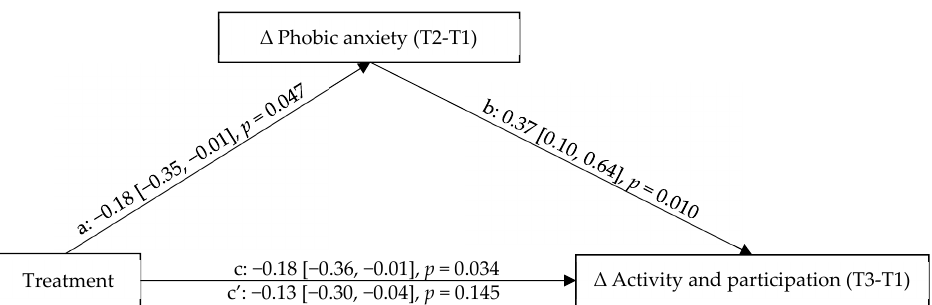
Figure 2. Mediated model with standardized regression coefficients predicting mediation effects of short-term change in phobic anxiety between treatment and long-term change in activity and participation. T1, baseline time point measurement; T2, 12-months follow-up time point measurement. T3, 18-months follow-up time point measurement.